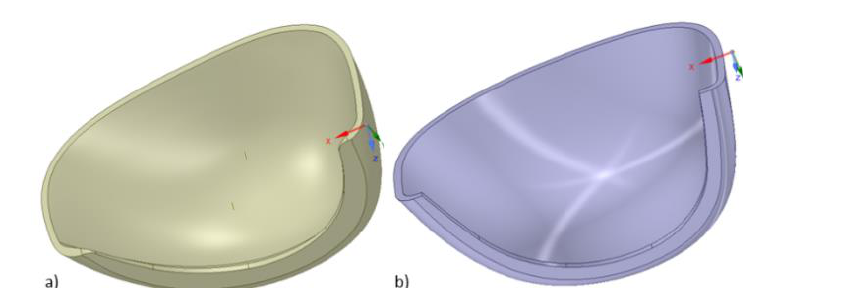
Figure 1. Toecap geometries reconstructed by means of 3D scanning: ( a ) type A — polymeric toe- caps, ( b ) type B — steel toecaps.